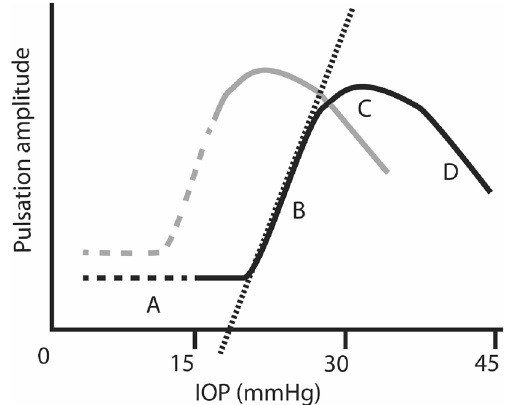
Figure 2. Schematic diagram of typical maximum pulse amplitude vs intraocular pressure curve. It is not usually possible to gain data from IOP below 15 mmHg so that is presumed and shown as dashed line. The black curve represents data from a subject with an elevated ICP of 19 mmHg, having a flat initial phase ( A ) then rising ( B ) to a peak ( C ) which then starts to drop ( D ) as IOP increases. Analysis aims to extract data from the rising segment ( B ), perform linear regression and extrapolate (dotted line) it back to the x-axis, where amplitude tends to zero and theoretically ICP = IOP. When ICP is lower (grey line), the curve shifts to the left and there may be